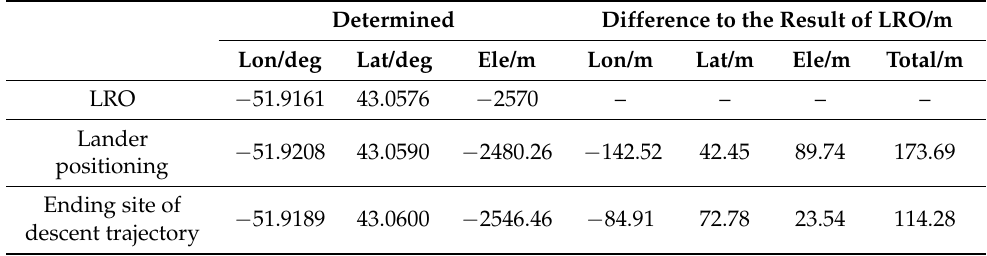
Table 3. Positioning result of CE-5 lander comparing with LRO and descent trajectory.